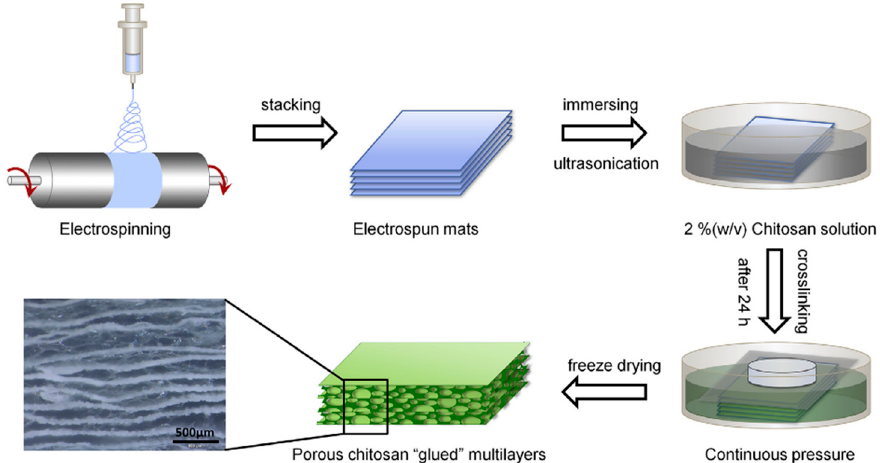
Figure 2. The schematic process of fabricating PCL–PEG nanofibers embedded 3D scaffold by incorporating PCL–PEG nanofibrous mats (aligned or random) into porous chitosan scaffold. The optical image displays a representative section view of the scaffold with width of 103.38 ± 49.54 μ m between layers. Reprinted with permission from Elsevier [109].